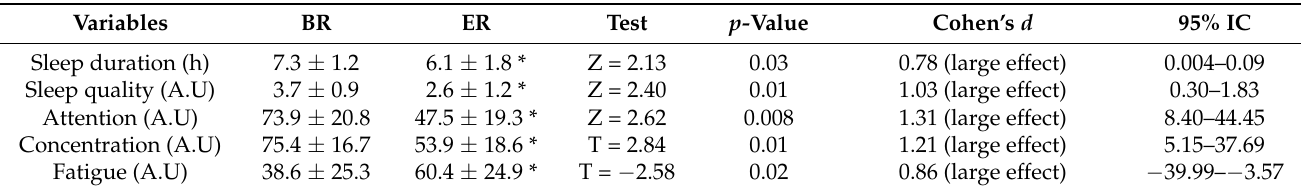
Table 3. The perceived levels of subjective attention, fatigue, sleep duration, sleep quality, and concentration recorded before Ramadan (BR) and at the end of Ramadan (ER).